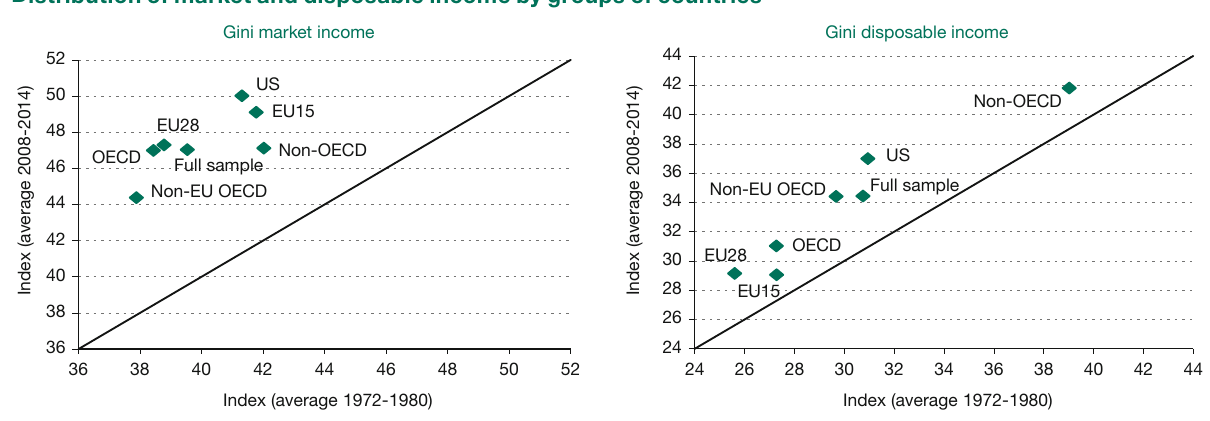
Figure 2 Distribution of market and disposable income by groups of countries